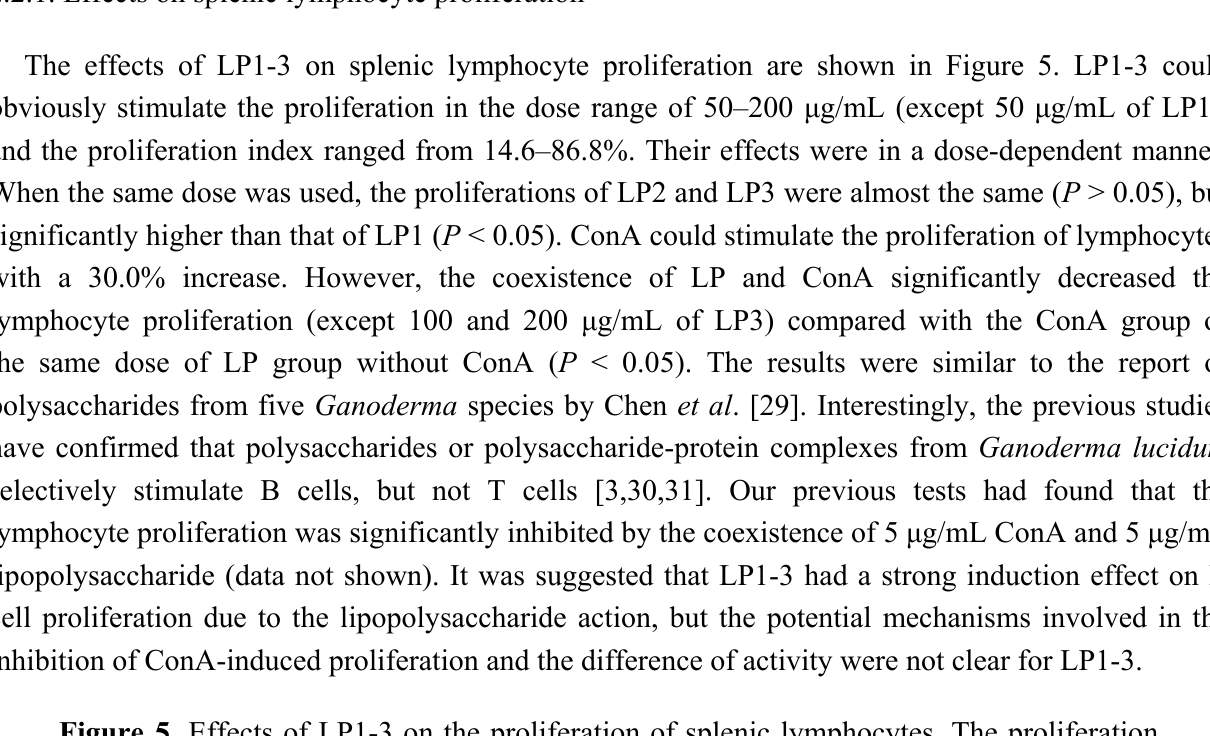
Figure 5. Effects of LP1-3 on the proliferation of splenic lymphocytes. The